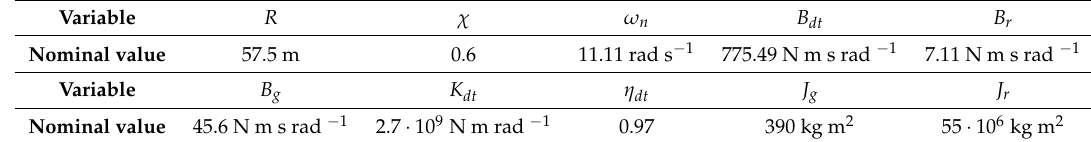
Table 1. Wind turbine benchmark parameters.